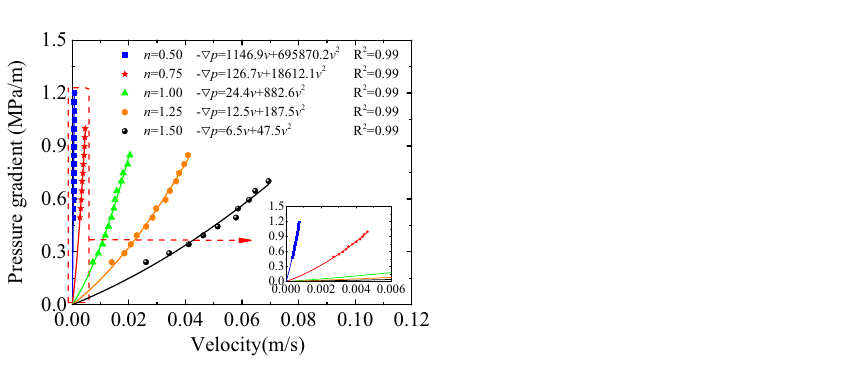
Figure 2. The relationship between pressure gradient and flow velocity under different power exponent of Talbol.